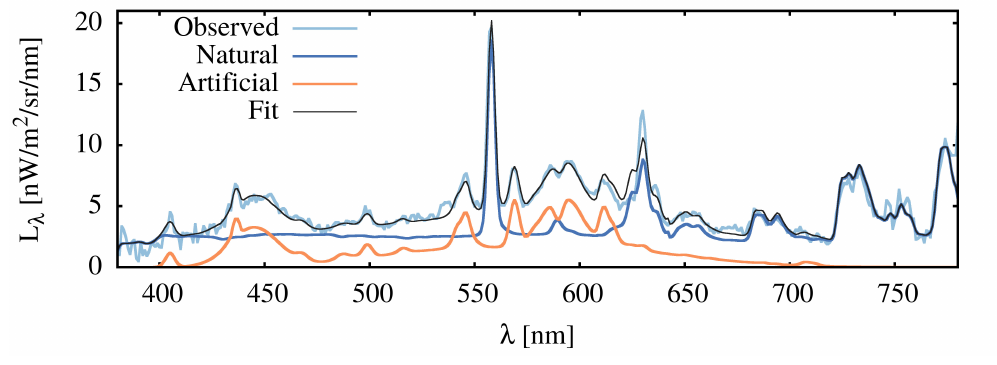
Figure 2. Decomposition of the zenith sky spectrum to the natural and artificial